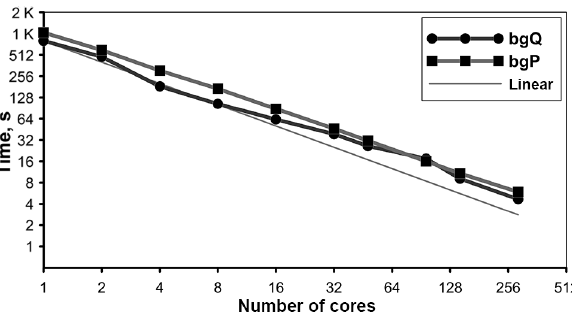
Figure 3. Wall-clock time required for the 10-day ocean– atmosphere model run with disabled physics vs. number of coupler cores on BlueGene supercomputers (Test I for